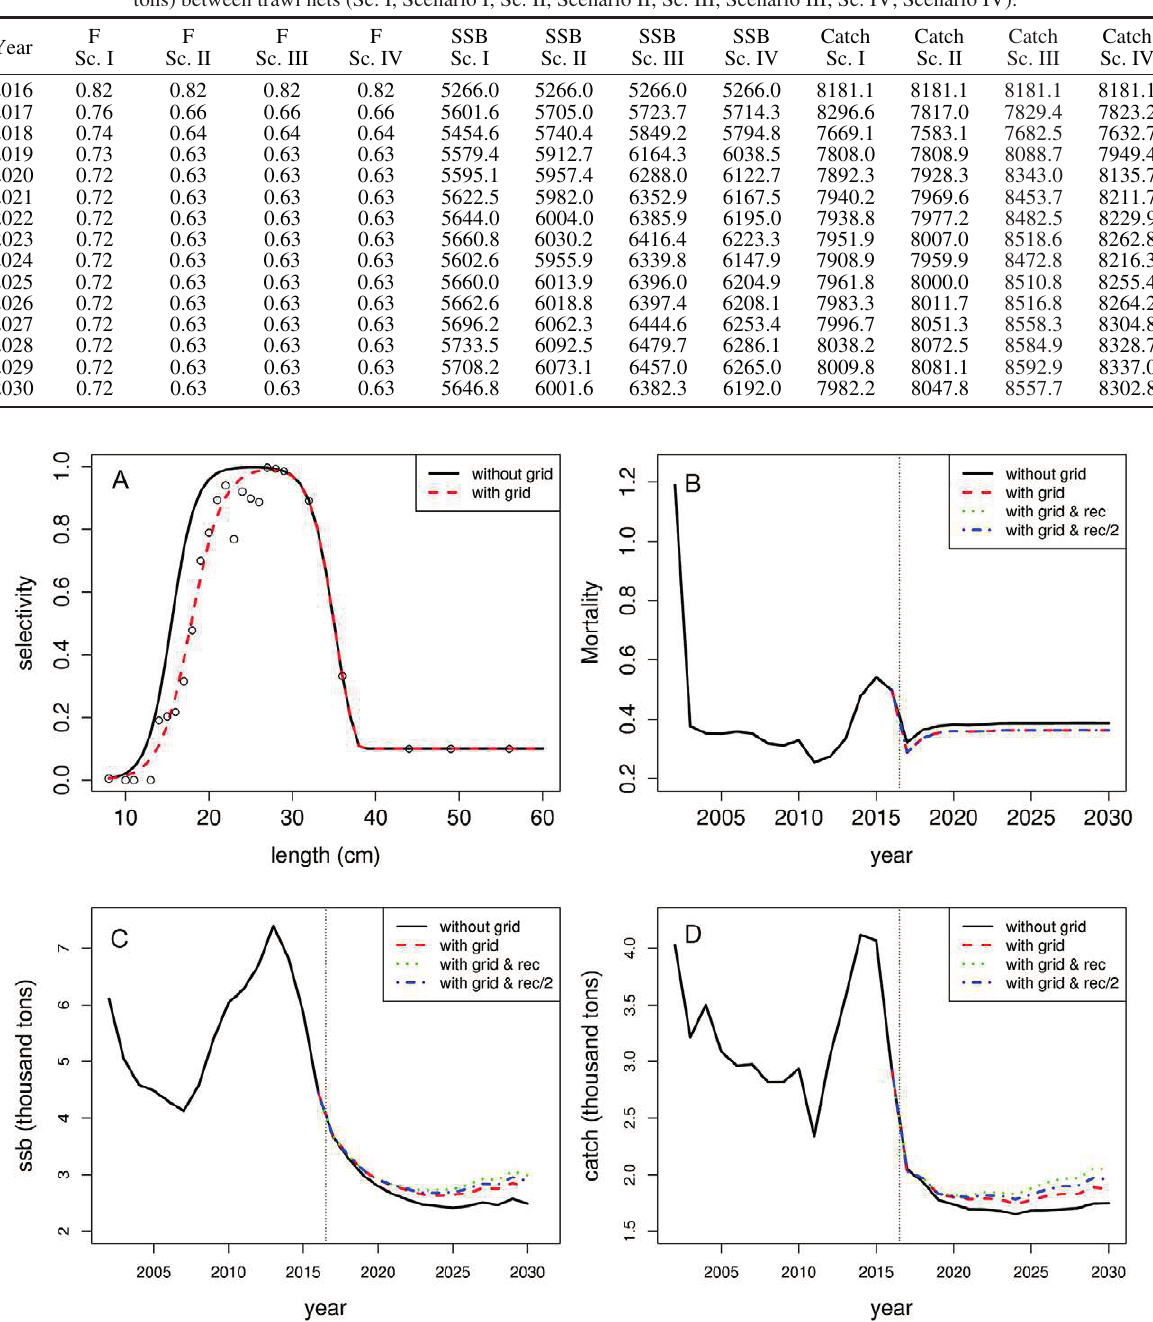
Table 3. – Summary of the main Gadget outcomes of DPS after survey with forecast from 2017 to 2030: F, SSB and Catch (expressed in metric tons) between trawl nets (Sc. I, Scenario I; Sc. II, Scenario II; Sc. III, Scenario III; Sc. IV, Scenario IV).